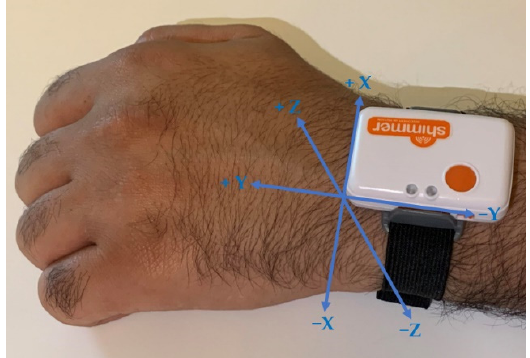
Figure 2. Axis orientation.